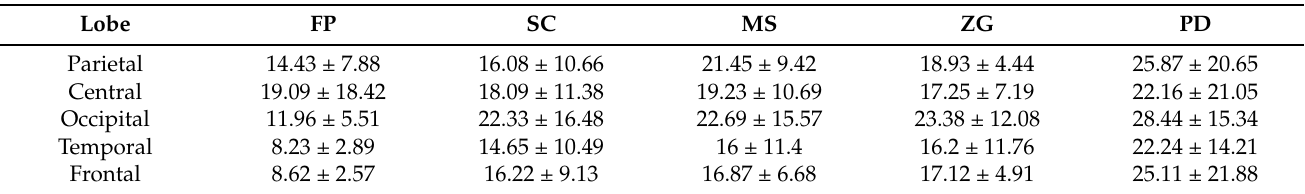
Table 5. Average results by cerebral lobes of the alpha band absolute power (µV2/Hz) for the signals of the games Finger Painting (FP), Sorting Cubes (SC), More Switches (MS), Zero Gravity Switches (ZG), and Punch the Dummy